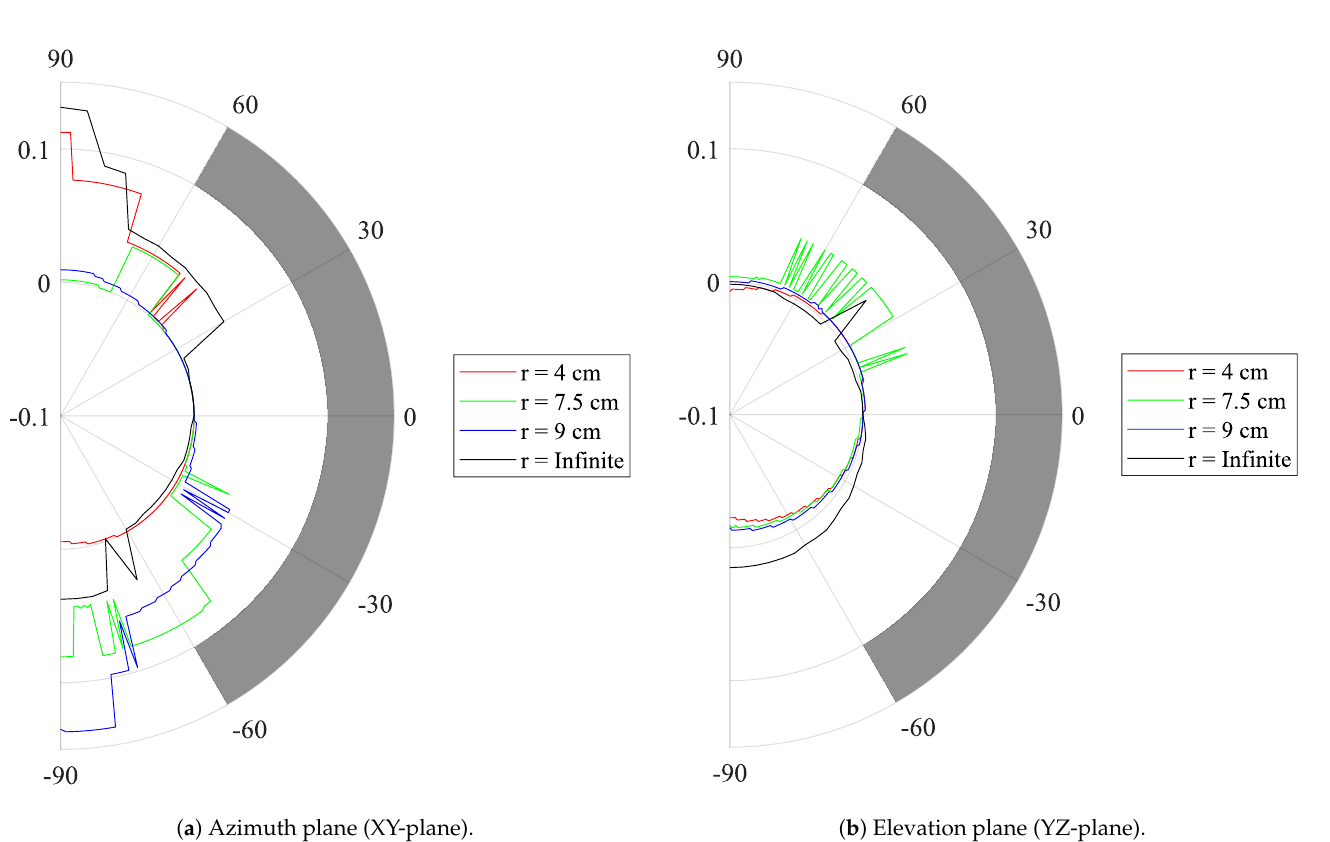
Figure 7. Measured Distance Estimation Error (DEE) (m) of the standalone antenna as a function of the respective angle. The broadside of the antenna radiation pattern is defined as having 0 cm deviation. Different bending radii r , frequently encountered on the human body, are applied. As a reference, the DEE < 10 cm goal is marked in